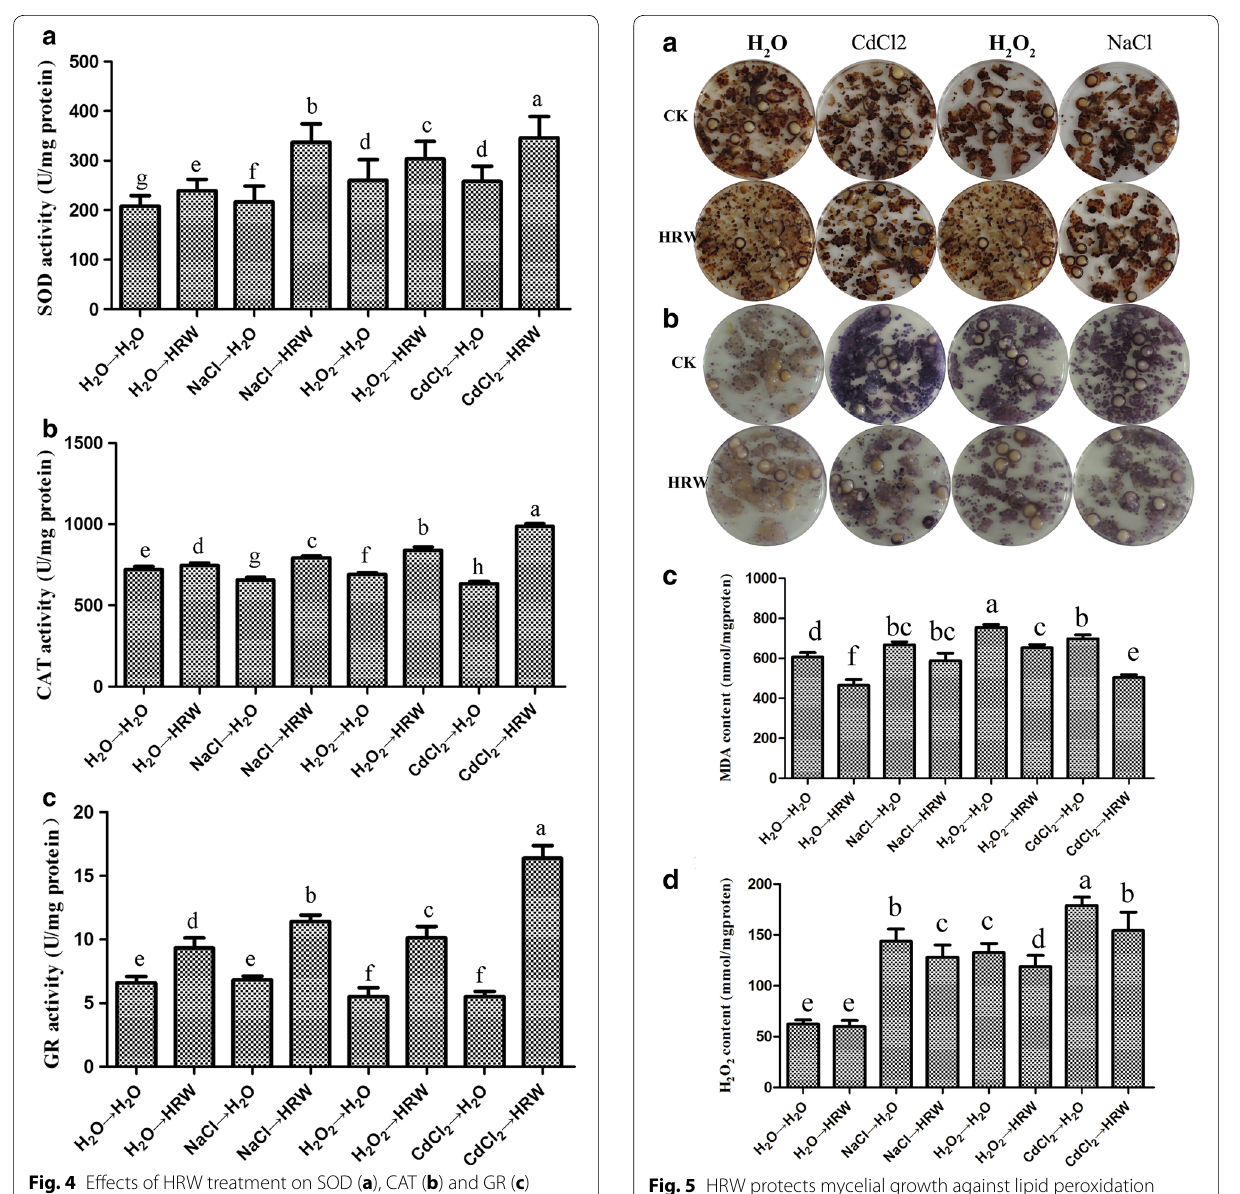
Fig. 5 HRW protects mycelial growth against lipid peroxidation and ROS homeostasis induced by CdCl 2 , NaCl and H 2 O 2 stresses in Hypsizygus marmoreus . Mycelia were pretreated with 50 μM CdCl 2 , 1% NaCl or 4 mM H 2 O 2 for 24 h and then exposed to ddH 2 O or HRW for another 48 h. The mycelia were stained with DAB ( a ) and NBT ( b ) and 48 h after various treatments to detect H 2 O 2 and O 2 − , respectively. Levels of lipid peroxidation (MDA) were measured at the indicated time points ( c ), and the levels of H 2 O 2 were also determined ( d ). Data are mean SE from three independent experiments. Bars with differ- ± ent letters are significantly different at P < 0.05 according to